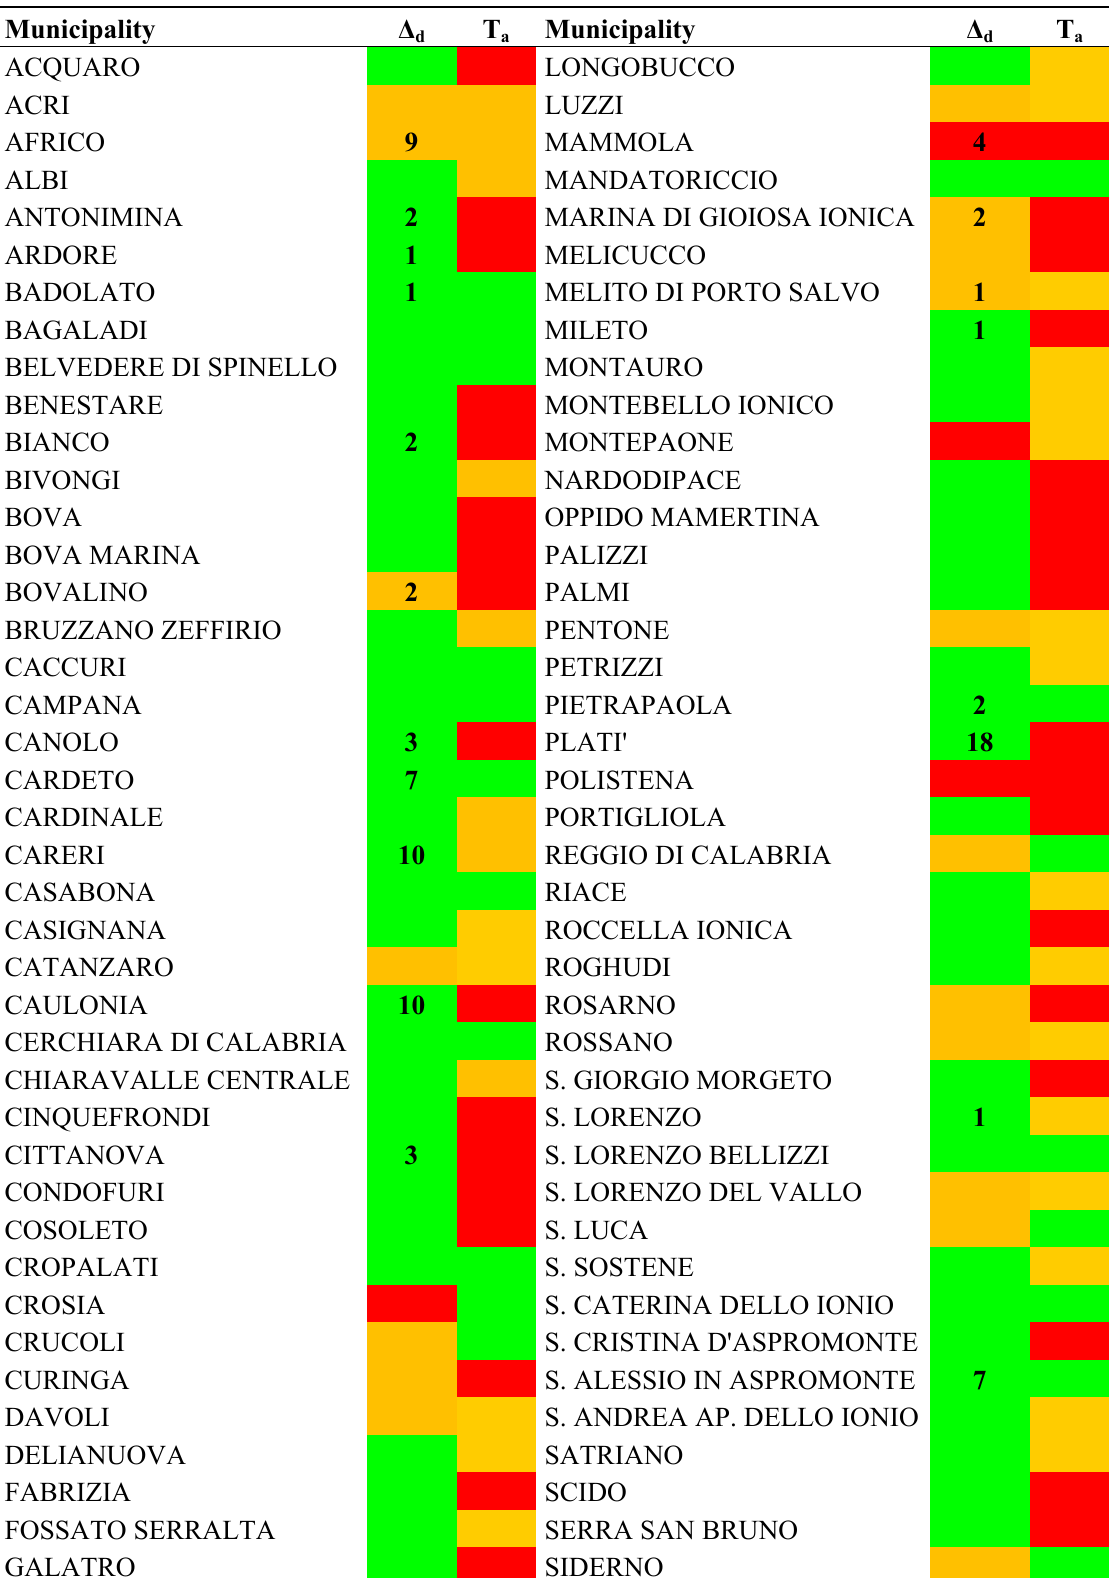
Table 4. The Calabrian municipalities affected by the 1951 event. The colors represent the values of the Δ and T classes, as in the legend; the numbers represent victims in each d a municipality in the 1951